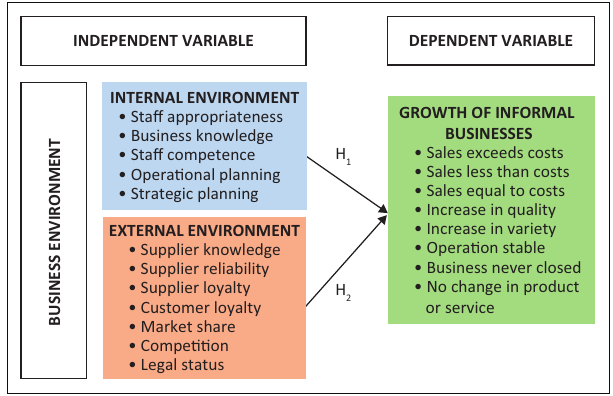
FIGURE 1: Theoretical framework of the relationships between the business environments and growth of informal